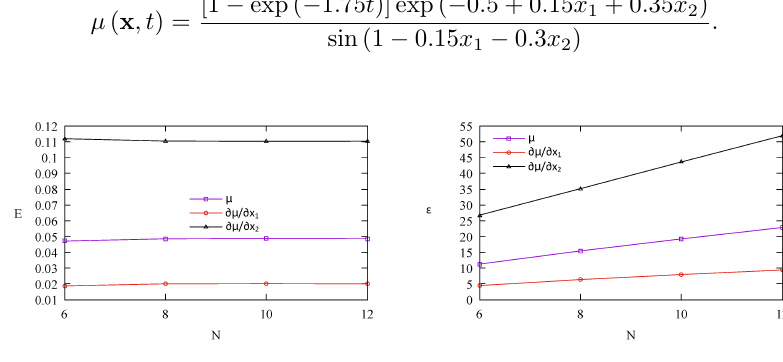
Figure 2. The aggregate relative error E and efficiency number ε = τE for Case